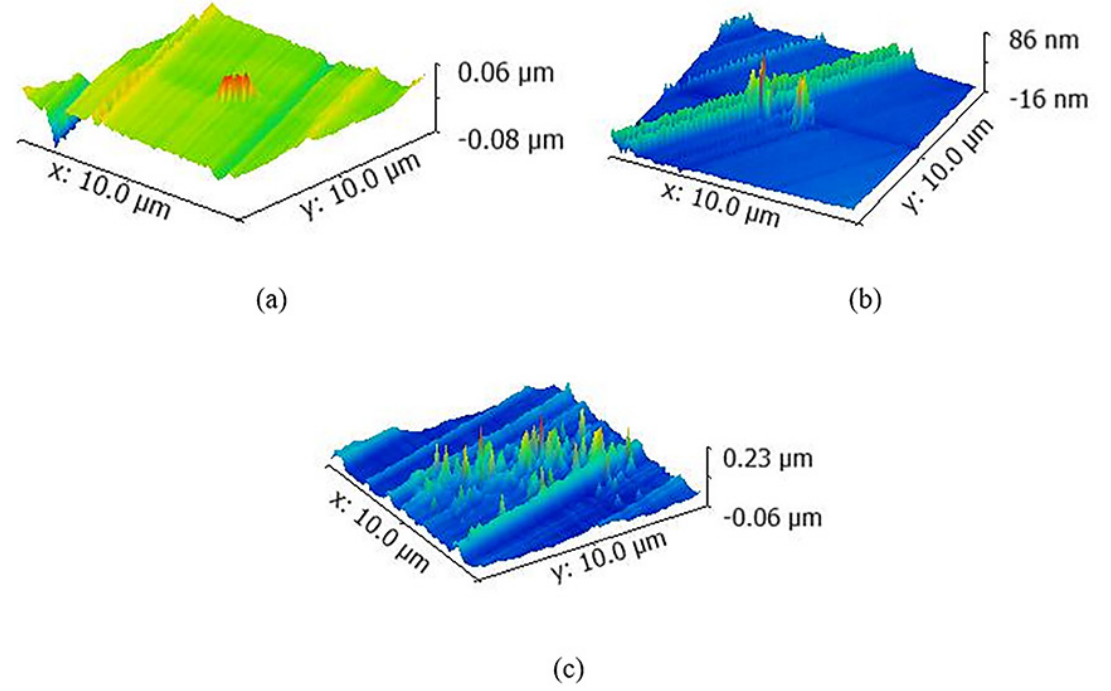
Figure 4. AFM Analysis: (a) Adhesive + 0.5 wt% CNT; (b) Adhesive + 1.0 wt% CNT; (c) Adhesive + 2.0 wt% CNT. In the images the z-axis represents the height of the